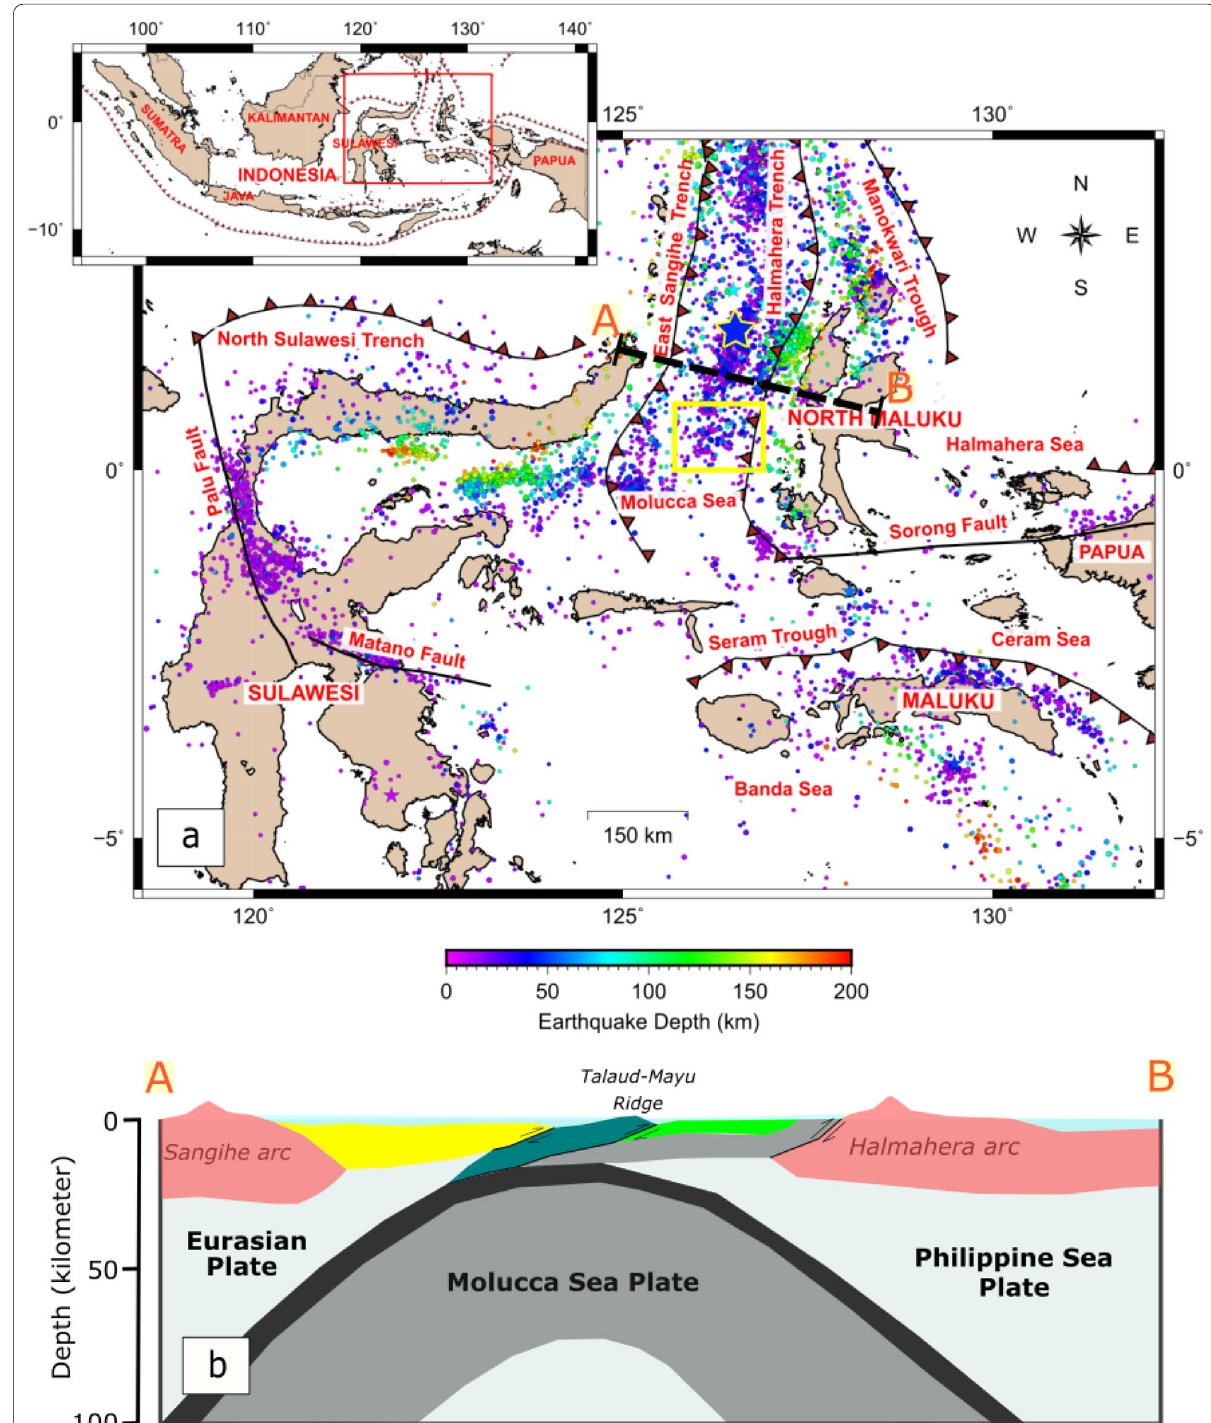
Fig. 1 a Relocated earthquakes of eastern Indonesia 2009–2018 with magnitude Mw > 4 from Supendi et al. (2020) shown by colored dots. The red rectangle in the inset presents the coverage area of the seismicity map. Black lines represent the plate boundaries. The yellow rectangle represents the location of this study. The blue star represents the largest recent earthquake in the Molucca Sea region (Mw 7.1), which occurred on November 14, 2014. b Illustration of A–B cross section of Molucca Sea that describes the structure of arc-arc collision zone (modified from Hall and Smyth 2008; Waltham et al.